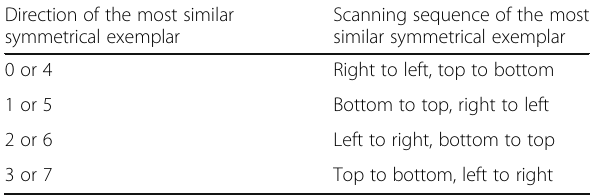
Table 1 Scanning sequence of the most similar symmetrical exemplar Direction of the most similar symmetrical exemplar 0 or 4 Right to left, top to bottom 1 or 5 Bottom to top, right to left